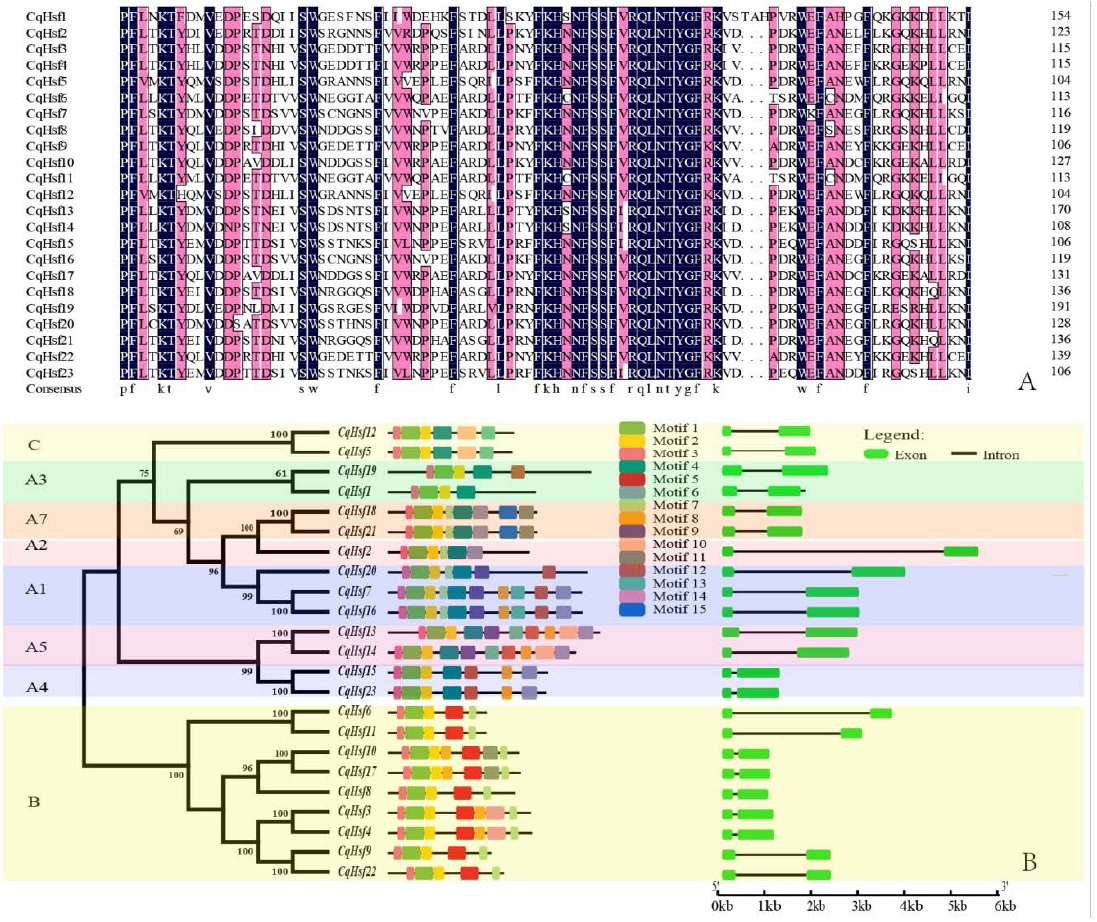
Figure 2. Multiple alignment, phylogenetic tree, conserved motifs, and gene structure of 23 CqHsf proteins. ( A ) Multiple alignment to identify the conserved functional domain DBD of CqHsf genes. ( B ) Phylogenetic tree, conserved motifs, and gene structure of CqHSf genes.